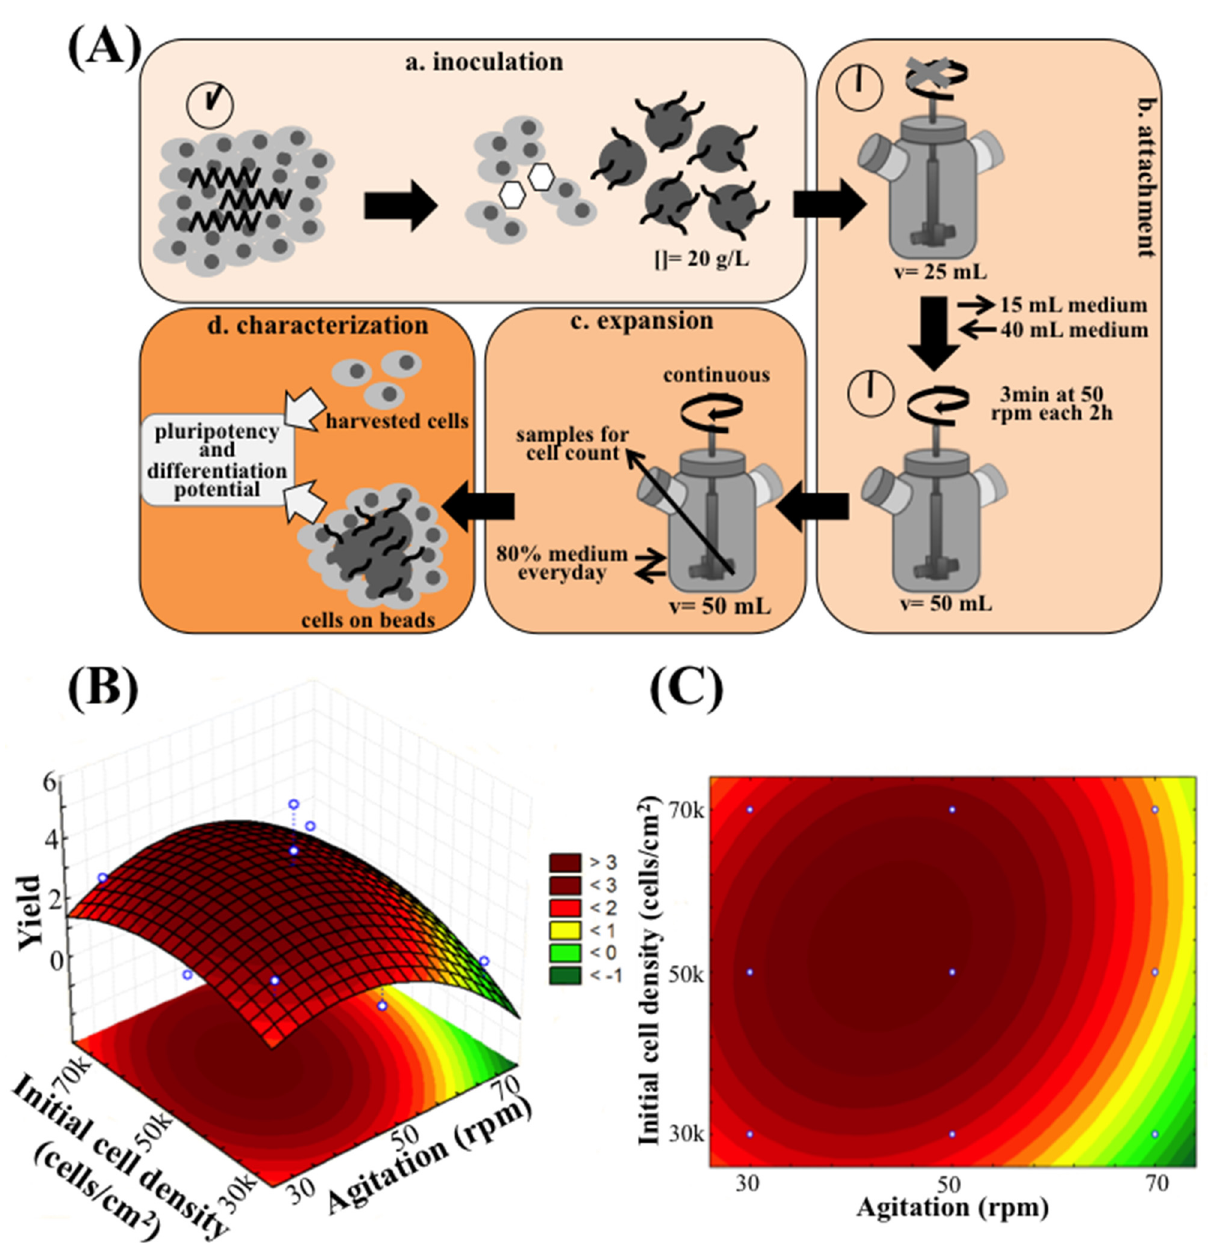
Fig 3. Scaling-up hiPS cell expansion in E8 medium to a 50 mL spinner flask, under dynamic conditions. (A) The procedure consists in 4 steps: a. EDTA+ROCKi inoculation strategy into 20 g/L VtnM; b. Attachment is performed in half of the total volume in static conditions for 24 h (in the presence of ROCKi), following by intermittent stirring overnight to allow cell- microcarrier interaction; c. Expansion is performed with a specific continuous agitation with 80% E8 medium change everyday; and d. At the end of the culture, cell pluripotency and differentiation potential are evaluated. Quadratic model relating initial cell density and agitation speed with cell yield during spinner flask culture of human iPS cells: 3D representation (B) and 2D heat map (C) are shown. For initial cell density: 30 000 cells/cm 2 ( − 1 level) (cid:3) Initial Cell Density (cid:3) 70 000 cells/cm 2 (1 level); for agitation speed: 30 rpm ( − 1 level) (cid:3) Agitation Speed (cid:3) 70 rpm (1